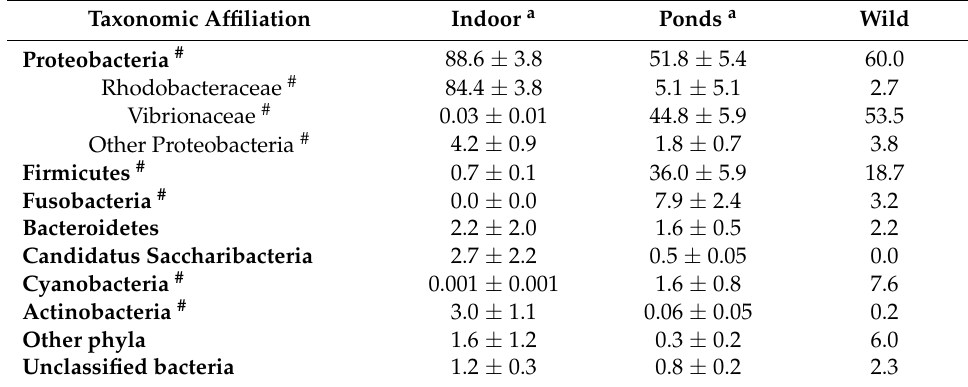
Table 3. Relative abundance (%) of main bacterial taxonomic groups in the intestinal tract of whiteleg shrimp raised under two different production systems and from a wild population.